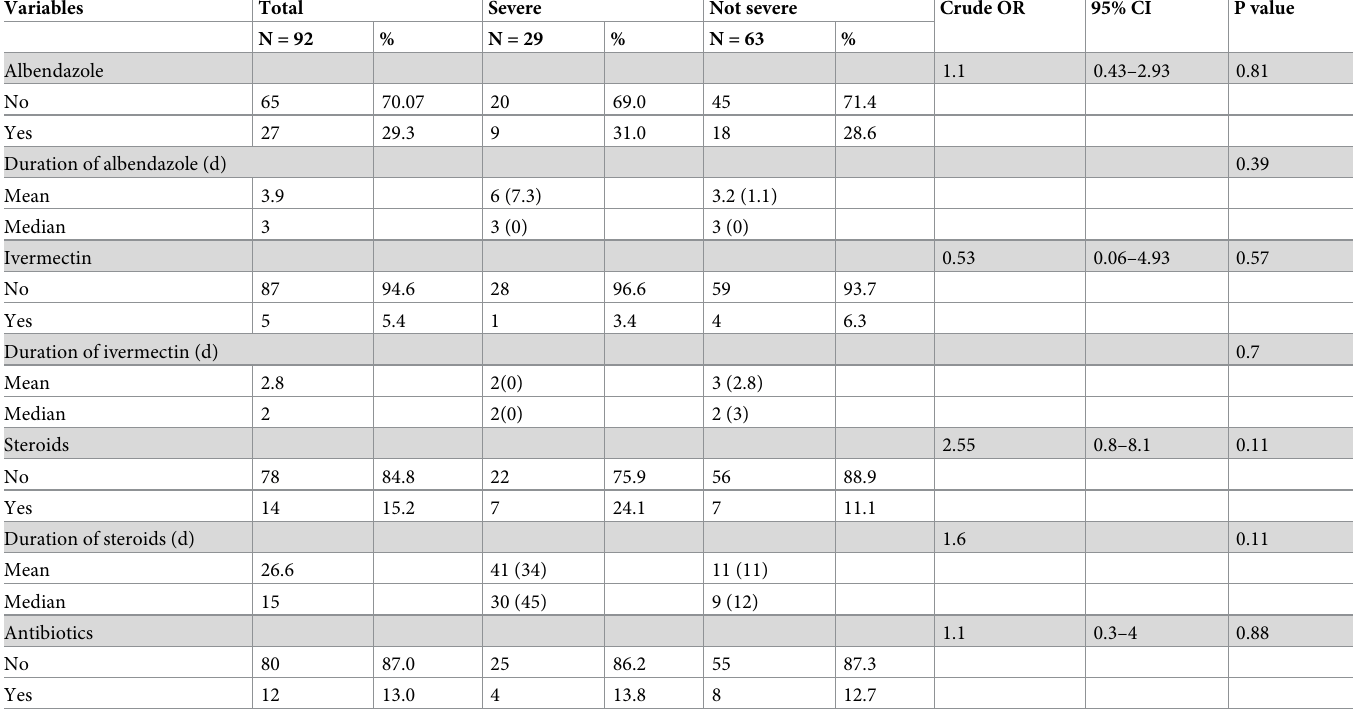
vs 12.34, p = 0.38), and a higher proportion of patients were admitted to the ICU (17.6% vs 5.2%, p = 0.18). Steroids were given in a higher proportion of cases (29.4% vs 11.6%, p = 0.15) and CT Scan were done more frequently (70 vs 41% of the cases of patients with EM, p = 0.16). The proportion of severe cases was not higher in this subgroup (29% vs 31%, p = 0.86). The multivariate analysis showed that increasing age (p = 0.001) and low CSF glucose level (p = 0.006) were associated with severe forms and that radiculitis (p = 0.007) and treatment with steroids (p = 0.02) were associated with death or sequelae (see S1 File). Table 5. Treatment of New Caledonian cases of EM according to severity, n = 92.